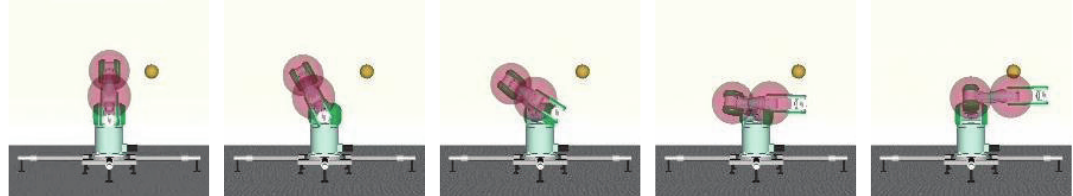
Figure 13: Scenes in Case 1 of obstacle avoidance simulation.